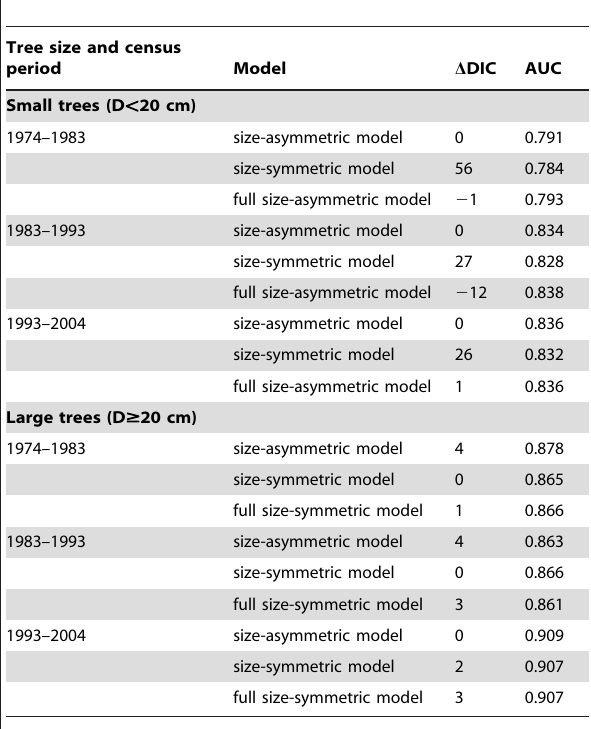
Table 1. Model selection statistics for alternative mortality